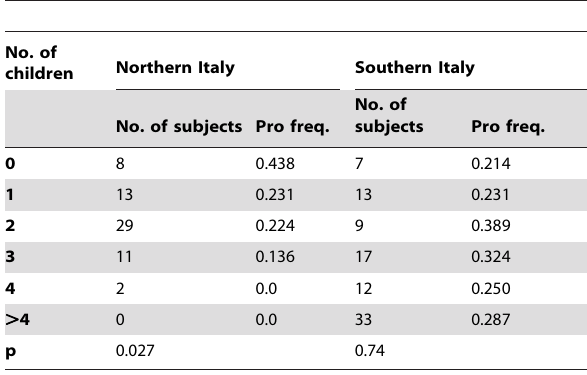
Table 3. P53 allele frequencies in subjects grouped according to number of